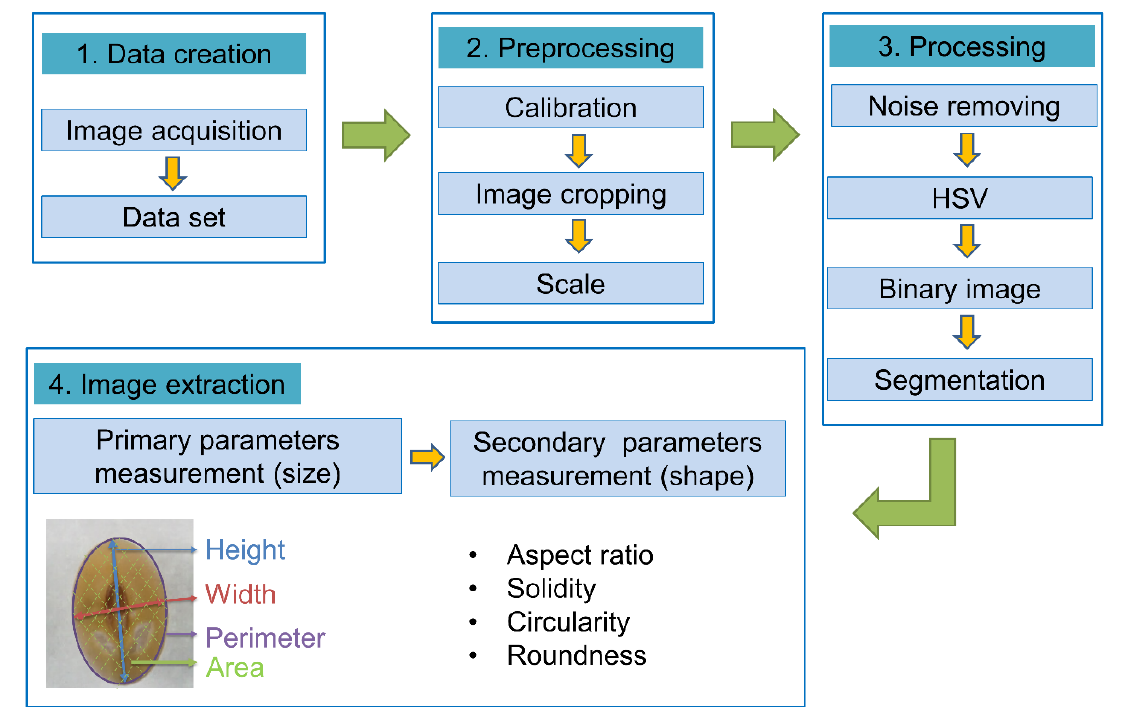
Figure 1. Pipeline for high-throughput phenotyping and soybean seed morphological indicators [20,23]. In the case of the image sample, the seed phenotype was extracted by data creation, preprocessing, processing, and image extraction with germplasm (IT153948). The measured values of the primary parameter were directly extracted from the seed, and the measured value of the secondary parameter was extracted by applying the formula of ImageJ (all data adapted from imageJ).